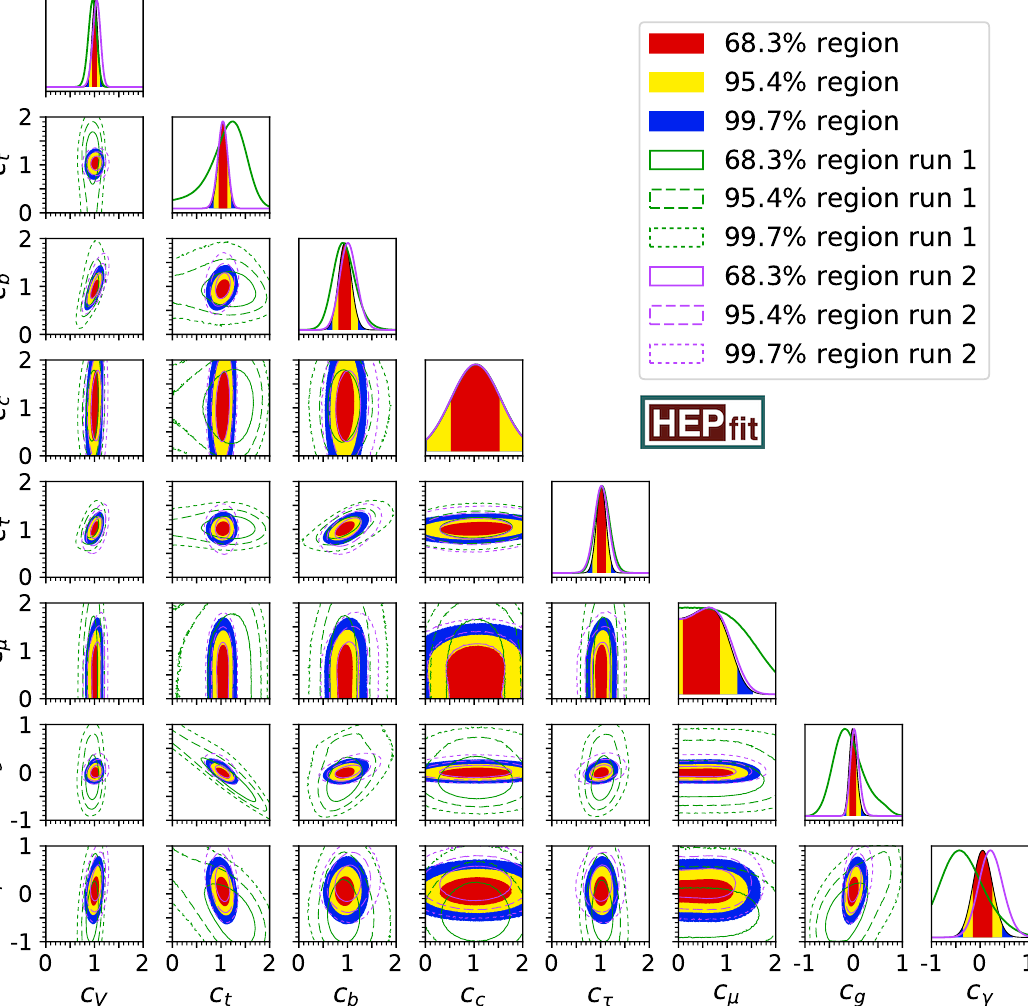
Figure 5 . For the parameters c i with i = V; t; b; c; (cid:28); (cid:22); g; (cid:13) we display the one-dimensional posterior distribution as well as their two-dimensional correlations. The regions allowed at 68.3%, 95.4% and 99.7% probability by current Higgs data are represented by the red, yellow and blue (cid:12)lled contours, respectively. Additionally, we show the single contributions from pre-13 TeV run data (green) and LHC run 2 data